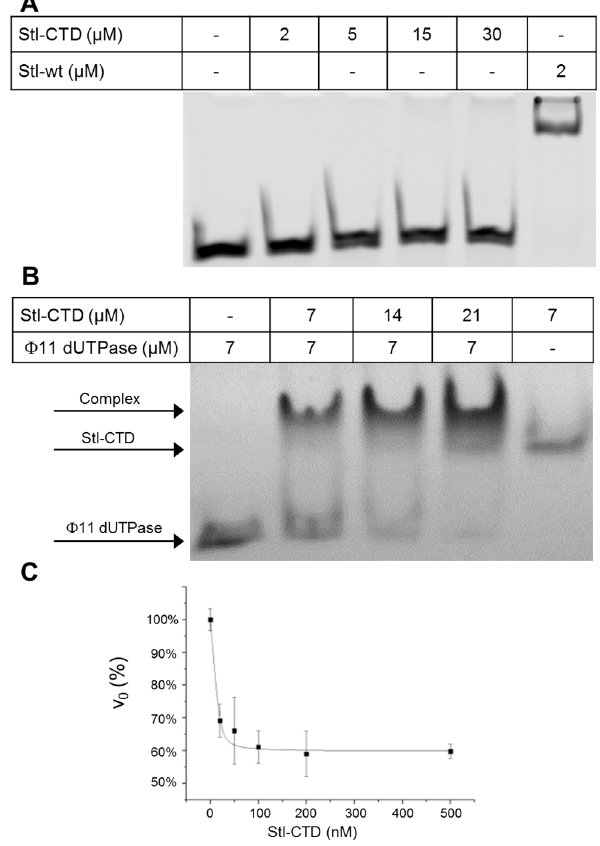
Fig 2. DNA and protein binding ability of Stl-CTD. (A) Electrophoretic mobility shift assay was performed to investigate the DNA binding ability of Stl-CTD. Species and concentrations given in monomers are indicated on the figure. The band of the dsDNA is only shifted upwards if wild type Stl is added but there is no shift even at high concentrations Stl-CTD. (B) Native gel electrophoresis experiment was performed to investigate the dUTPase binding ability of Stl-CTD. Species and concentrations given in monomers are indicated. The mixture of Stl-CTD and Φ 11 dUTPase shows up in distinct position comparing to the individual proteins, which clearly indicate the complex formation. (C) Activity of the Φ 11 dUTPase was measured in the presence and absence of Stl-CTD. Each measurement was repeated three times. The quadratic binding equation was fit to the data resulted in the apparent K i = 1.5 ± 0.5 nM. The total change in amplitude of the activity was